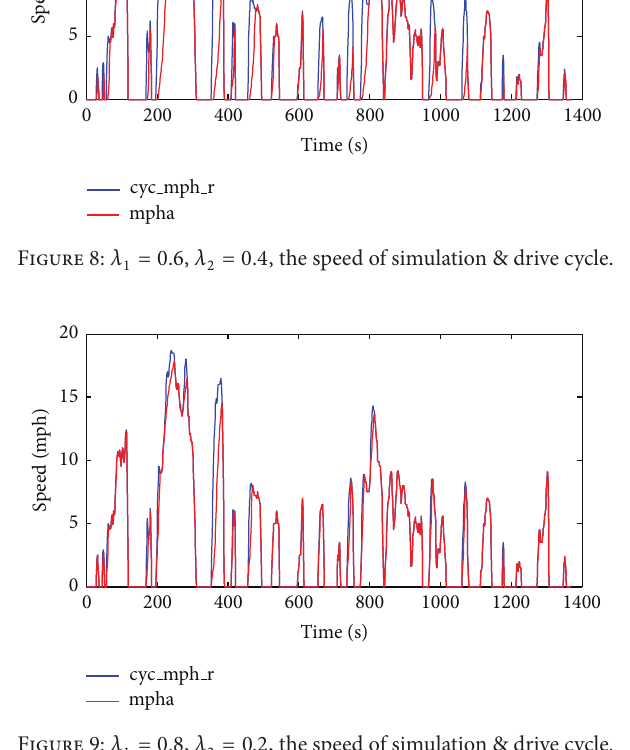
consumption, and in this case, a 3 kW is optimal to be selected as the rate power of the motor.